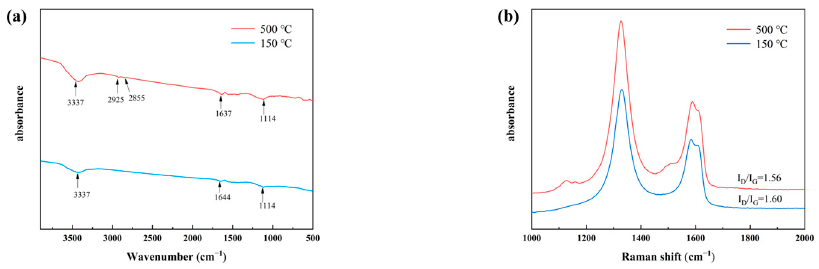
Figure 5. RGO heat-treated at different temperatures of ( a ) FTIR and ( b ) Raman